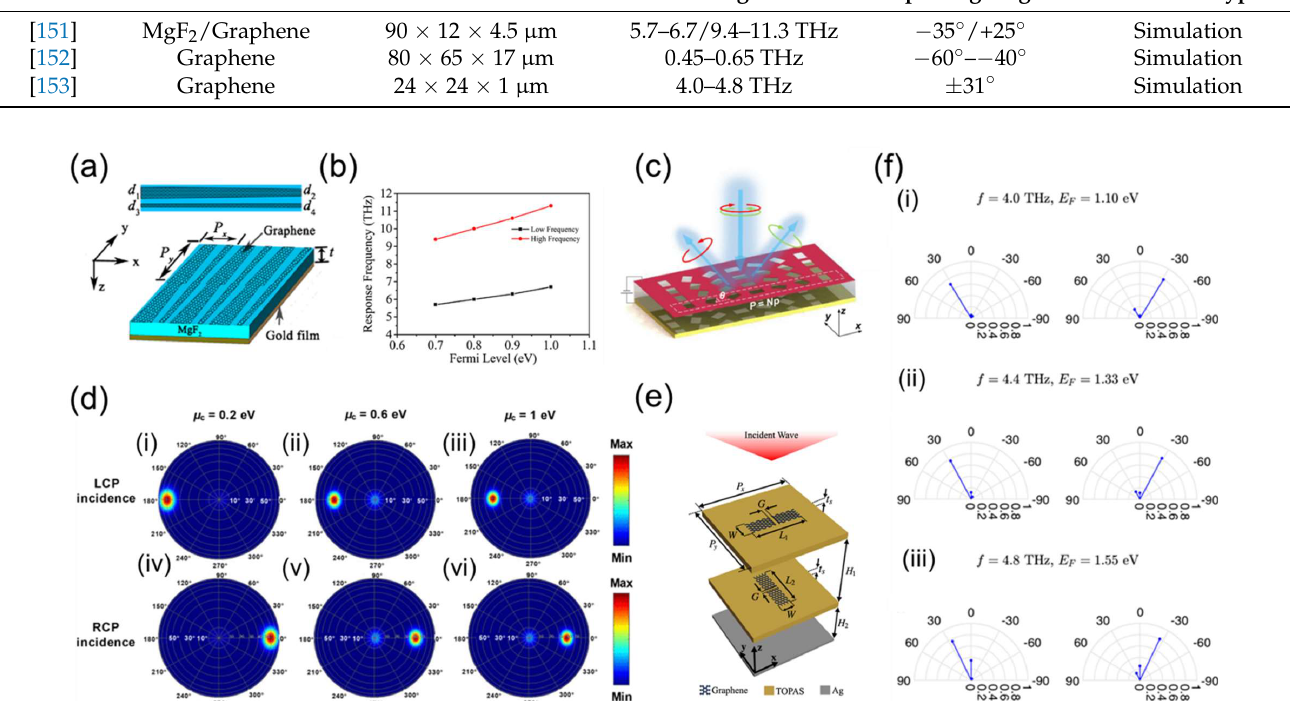
Figure 21. ( a ) Top view of the unit cell and schematic diagram of the designed metasurface beam splitter [151]. ( b ) The center frequency of the low–frequency and high–frequency responses as a function of the Fermi level of the graphene ribbon [151]. ( c ) Schematic diagram of a circular polarization beam splitter based on apertured graphene arrays; the dotted rectangle represents a super period [152]. ( d ) Far–field distribution under LCP ( i – iii )/RCP ( iv – vi ) ligh incidence, respectively [152]. ( e ) A unit cell of a two–layer metasurface, where the slotted patches on each layer are orthogonal to each other, and the layers are spaced a certain distance from the metallic reflector (Ag) [153]. ( f ) ( i – iii ) Corresponding angular spectra of reflected waves for TM and TE polarizations at three frequencies and three Fermi levels [153].